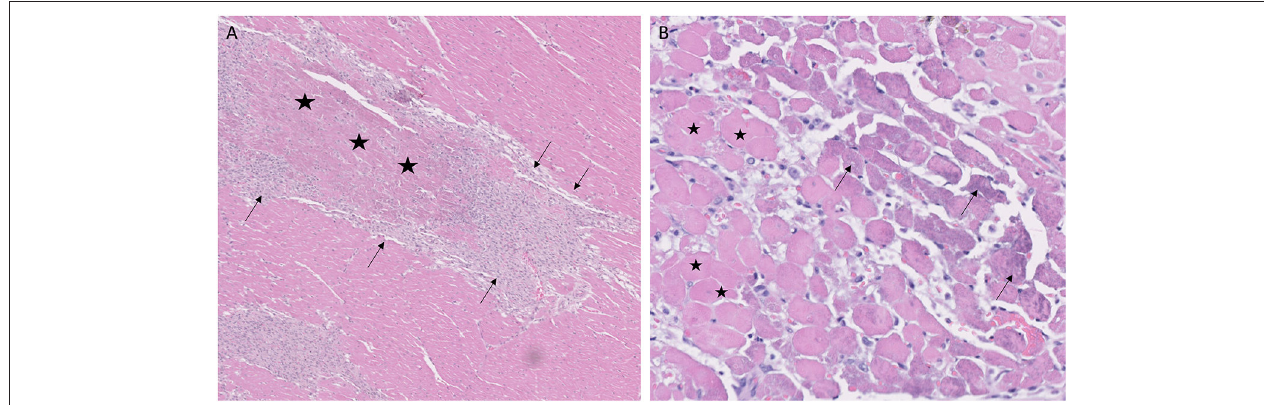
FIGURE 4 | Coagulative myocardial necrosis was a feature in some Golden Retriever muscular dystrophy hearts. (A) Areas of infarct-like coagulative necrosis characterized by loss of cytoplasmic detail and maintenance of tissue architecture (stars) are surrounded by proliferating macrophages and pericytes (arrows); H&E, × 5 magnification. (B) Acute coagulative necrosis with loss of nuclei and hypereosinophilic cytoplasm (representative cells with stars); cells on the margins of lesions have granular basophilic mineralization (arrows). 1-year-old female, H&E, × 20 magnification.